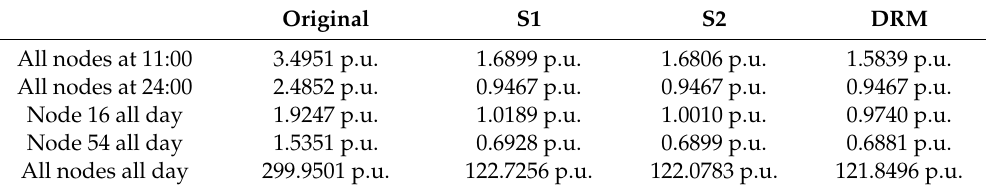
Figure 14. The daily voltages of Node16 and Node54 from three strategies. Table 5. Voltage deviation results of three